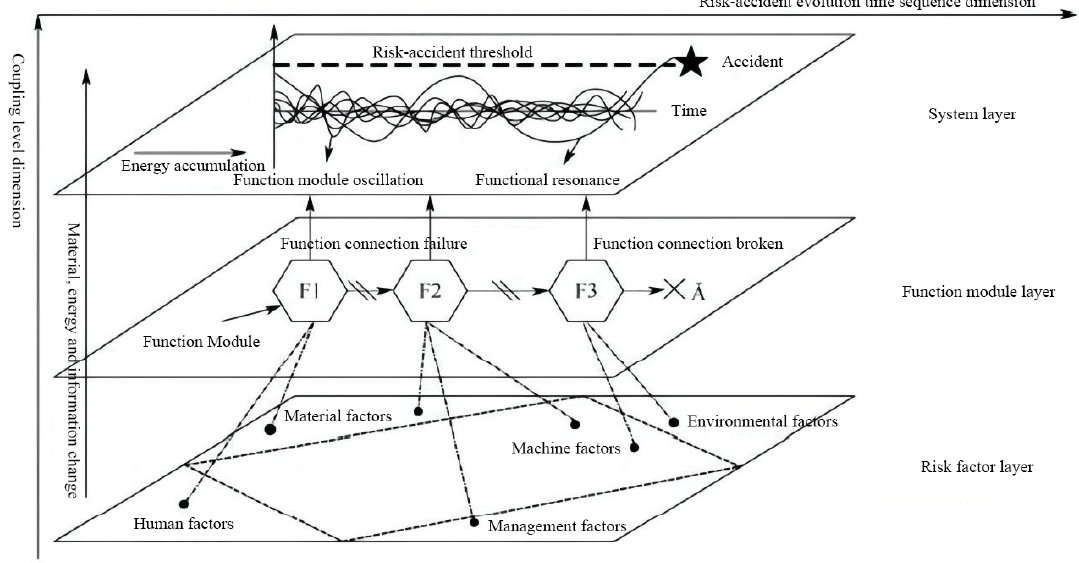
Figure 1. The FRAM functional resonance accident model.